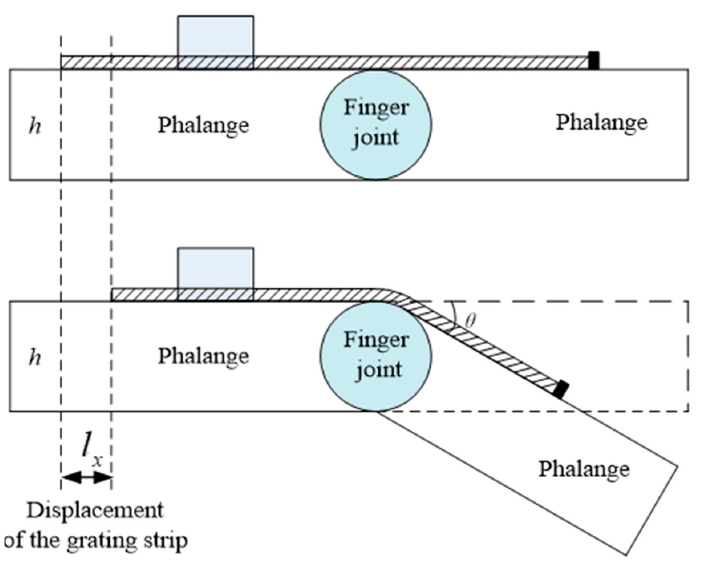
Figure 5. The diagram of conversion from displacement to angle.